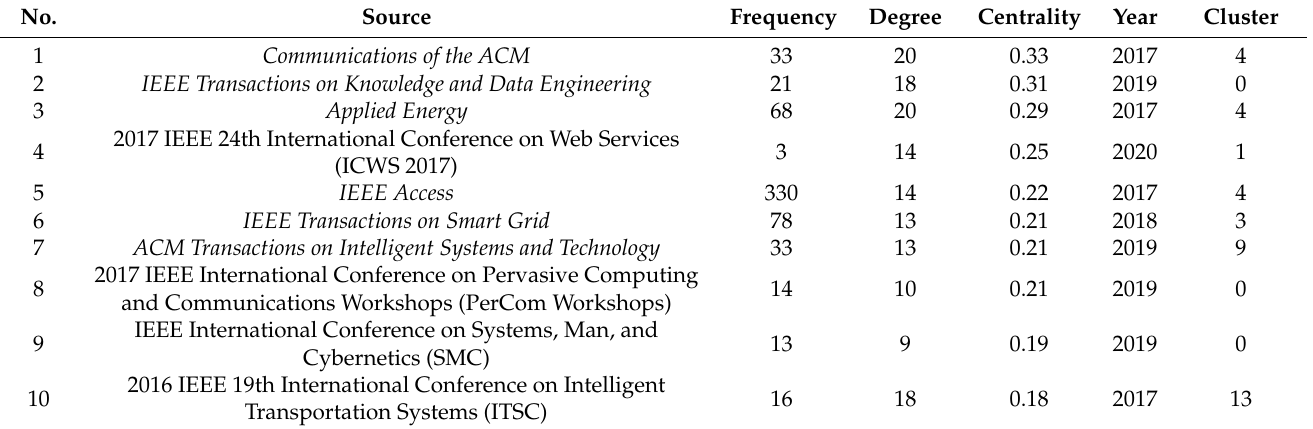
Table 6. Top ten co-cited sources with the highest betweenness centrality